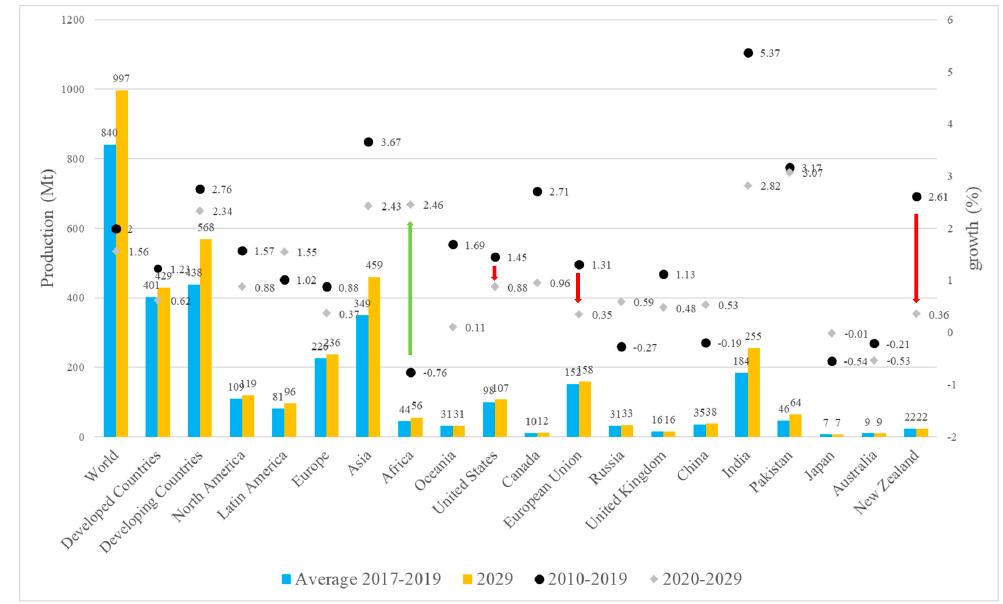
Figure 10. Global milk production and growth in selected regions and countries.